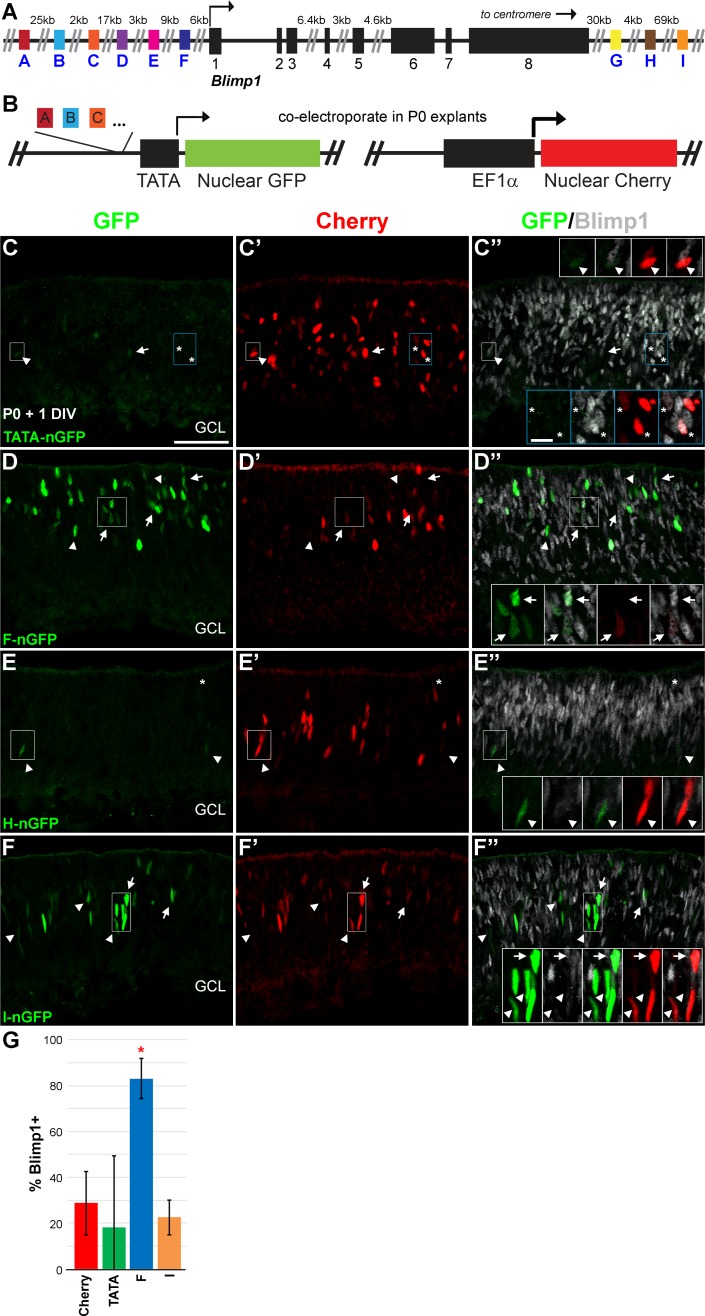
Screen for Blimp1 retina-specific enhancers.(A) Schematic of the Blimp1 genomic locus on mouse chromosome 10 showing nine DNase hypersensitive sites (DHS) near the gene. (B) Schematic of the retinal explant enhancer assay. The nine DHS sequences (A-I) are inserted upstream of a TATA box minimal promoter driving nuclear-localized GFP (nGFP). A separate plasmid contains the ubiquitous EF1α regulatory element driving nuclear-localized Cherry expression. Constructs are co-electroporated into P0 retinal explants and collected for histological analysis after one day in vitro (DIV). (C-C”) Co-electroporation of TATA-box only (no enhancer) and cherry plasmids. GFP+ nuclei (green) are rarely observed and express GFP at low levels. In contrast, Cherry+ nuclei (red) are widely distributed. Most GFP+ cells do not co-express Blimp1 (grey, arrowheads, insets), but about 25% are co-labeled (arrows). A similar fraction of Cherry+ cells co-express Blimp1 (asterisks, insets). This represents the probability that electroporated plasmids will end up in Blimp1+ cells by chance after 1 DIV. (D-D”) Element F drives strong GFP expression in explants and most of these cells co-express Blimp1 (arrows, insets). Arrowheads mark GFP+ cells that do not co-express Blimp1. (E-E”) Element H drives little GFP expression and the few positive cells do not co-express Blimp1 (arrowheads, insets). Blimp1+ cells are electroporated, as Cherry+ cells co-express Blimp1 (asterisks). (F-F”) Element I showed robust GFP expression with nuclei localized to the middle of the retina. Some GFP+ cells co-express Blimp1 (arrows, insets), but about 80% are Blimp1 negative (arrowheads, insets). GCL, ganglion cell layer. Scale bar is 50 μm for panels and 10 μm for insets. (G) Plot of the average percentage of GFP+ or Cherry+ cells that co-express Blimp1 for the active elements. Error bars represent the standard deviation (S.D.). Only element F shows a significant enrichment of Blimp1 co-expression compared to Cherry and TATA box GFP controls (*, unpaired t-test, P <0.001). The high standard deviation in the TATA only condition is due to the paucity of GFP+ cells.